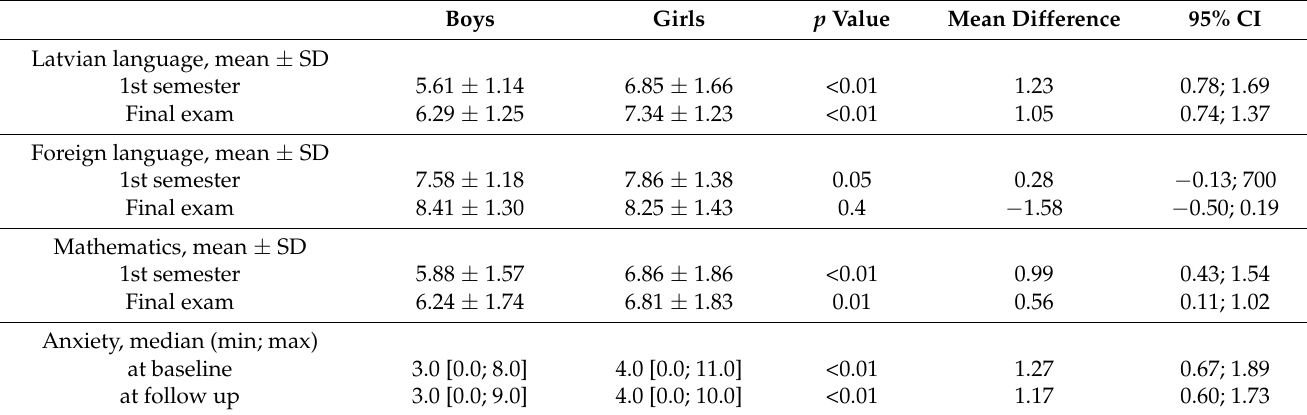
Table 3. Differences in grades, anxiety, and QOL, by